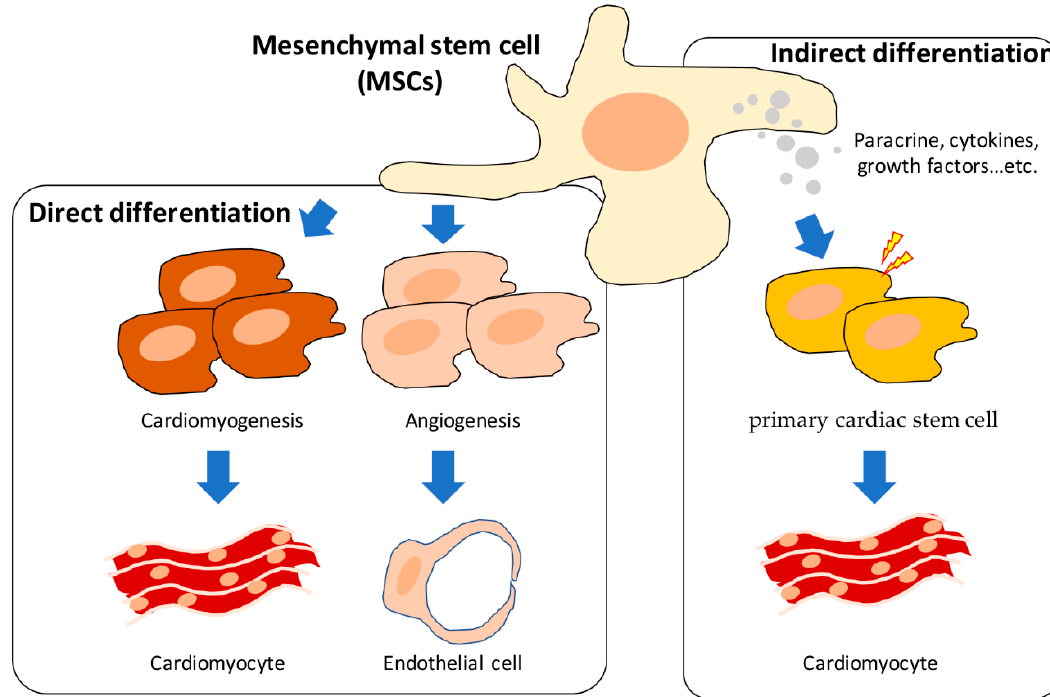
Figure 1. The direct and indirect differentiation of mesenchymal stem cells (MSCs) in cardiac tissue regeneration.